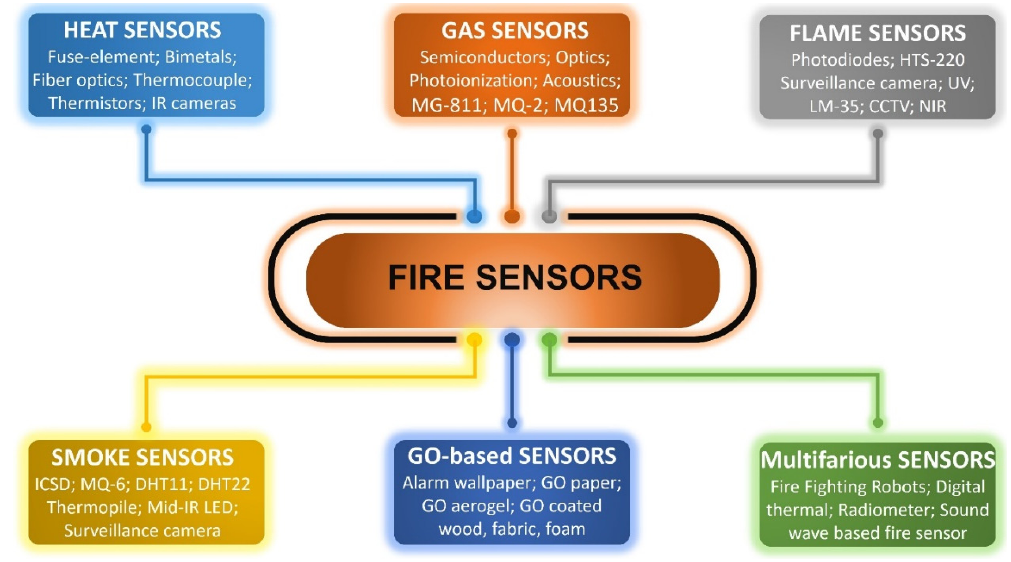
Figure 2. A summary of current fire sensing technologies.